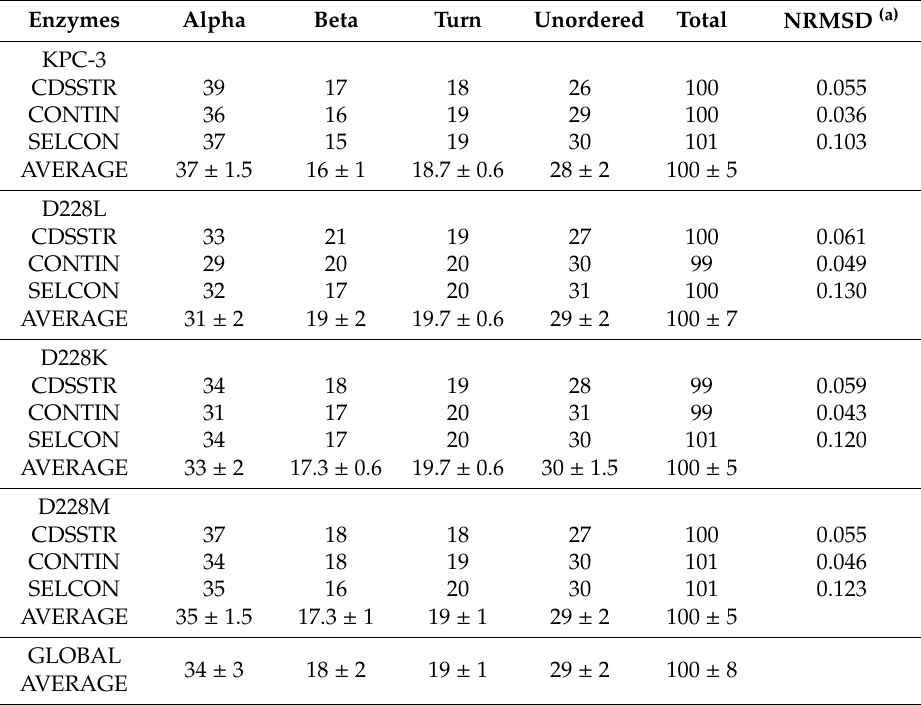
Table 2. Calculated secondary structures derived from the far-UV CD